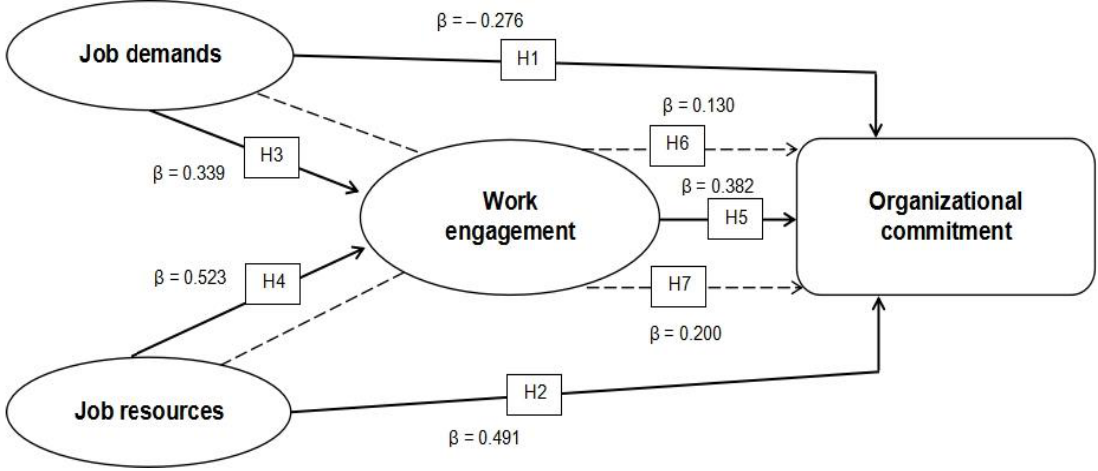
Figure 1: Summary of Model